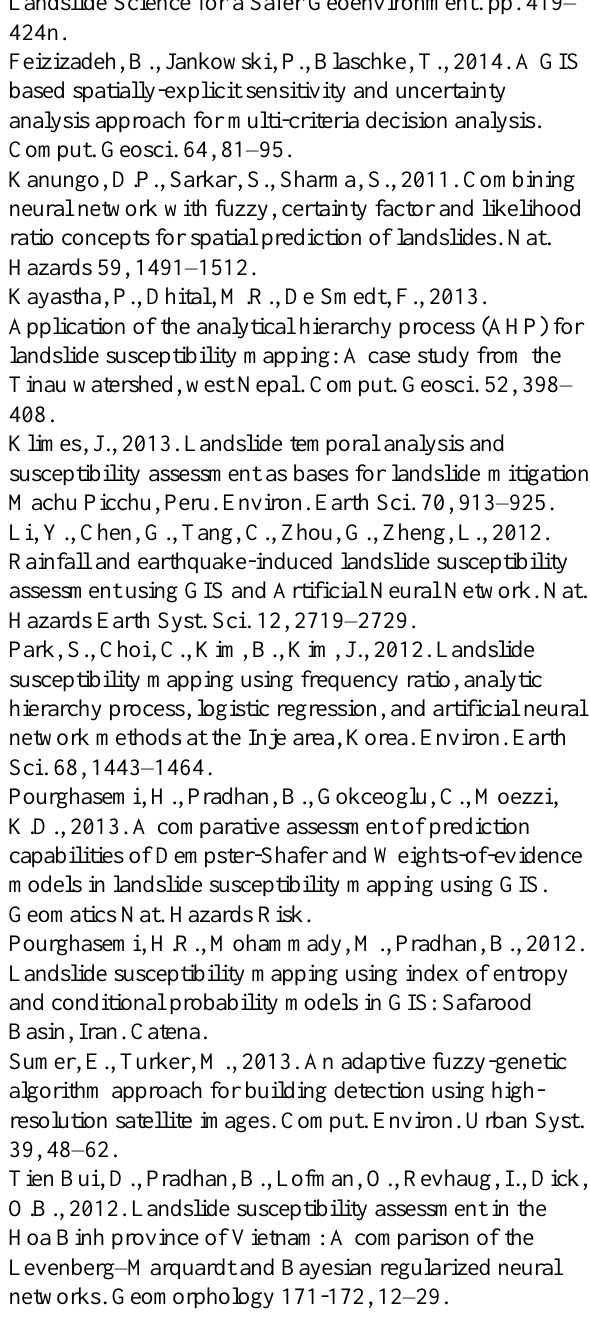
Table 1. The quality and resolution of DEM affecting on the LSM